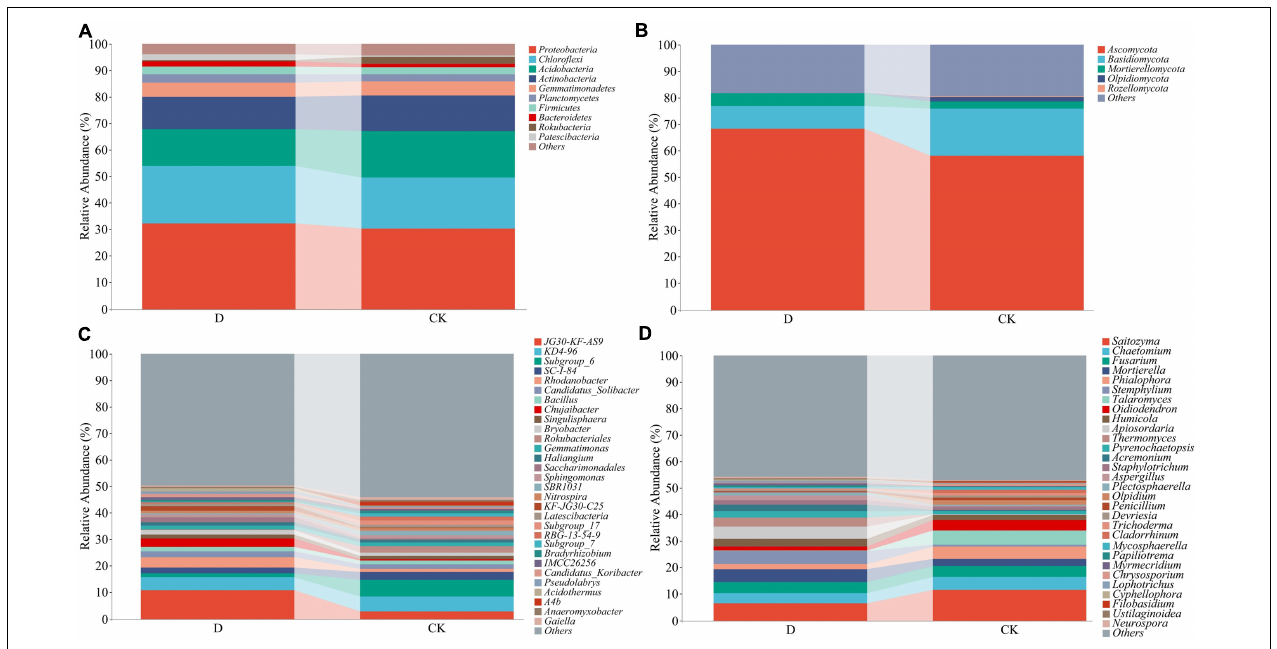
FIGURE 3 | The relative abundances of bacterial and fungal phyla and genera in the garlic cropping obstacle soil (D) and healthy control soil (CK). (A) Bacterial phyla, (B) fungal phyla, (C) bacterial genera, (D) fungal genera.